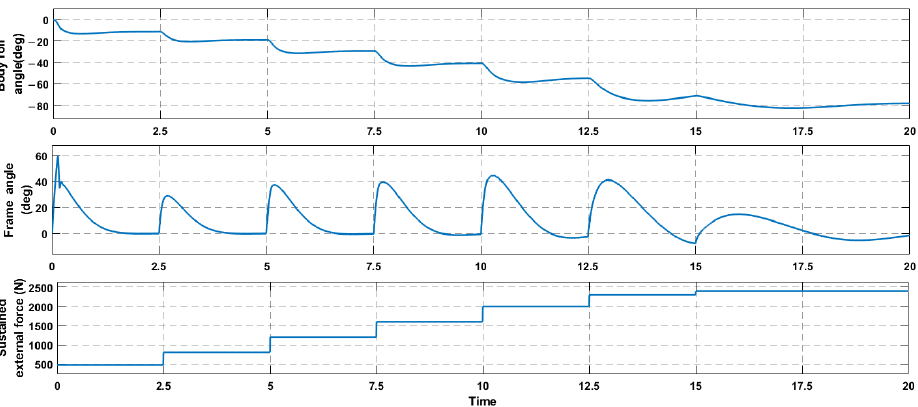
Figure 15. Simulation results: Self-balancing process of the vehicle body under the continuous external disturbance.